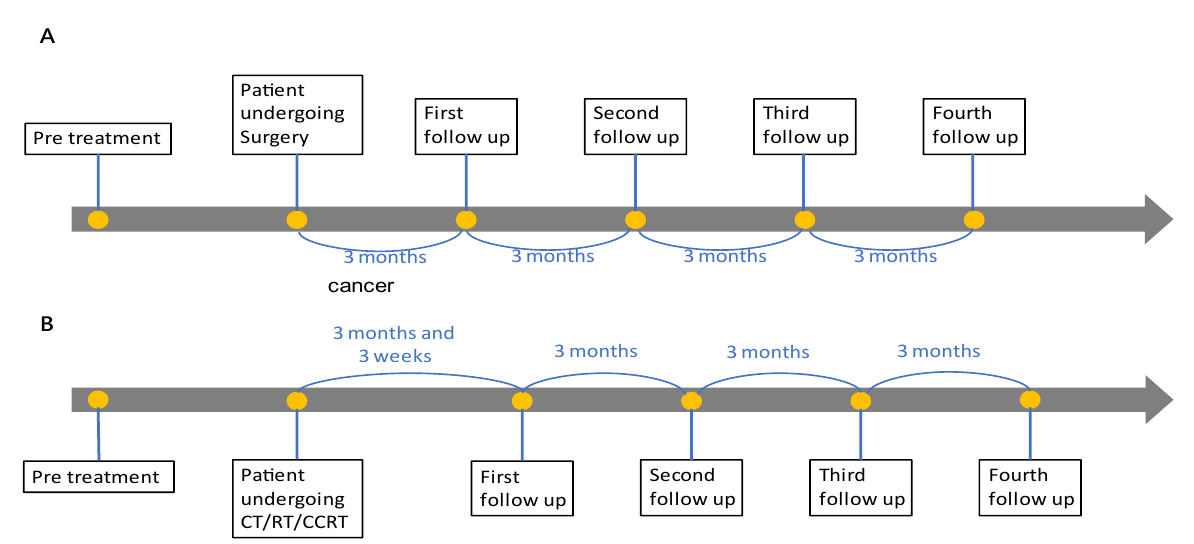
Figure 7. Different follow-up schemes for ( A ) surgical intervention and ( B ) other treatment